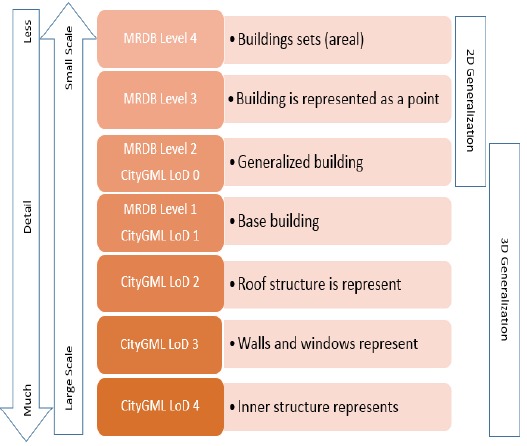
Figure 3. MRDB representation levels and CityGML detail levels for building object.